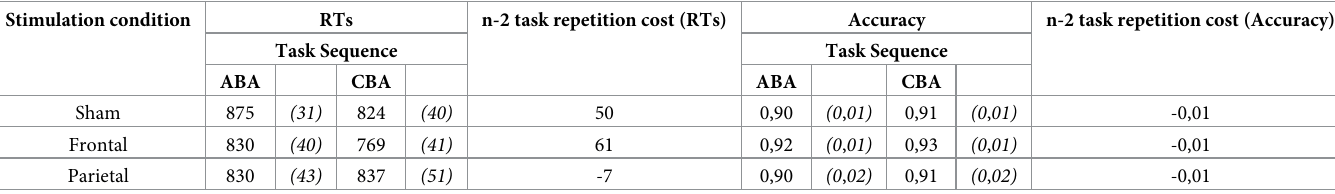
Table 1. Mean reaction times, accuracy and n-2 task repetition costs as a function of the stimulation (sham, frontal and parietal) and the task sequence (ABA and CBA). Standard errors are in brackets. Stimulation